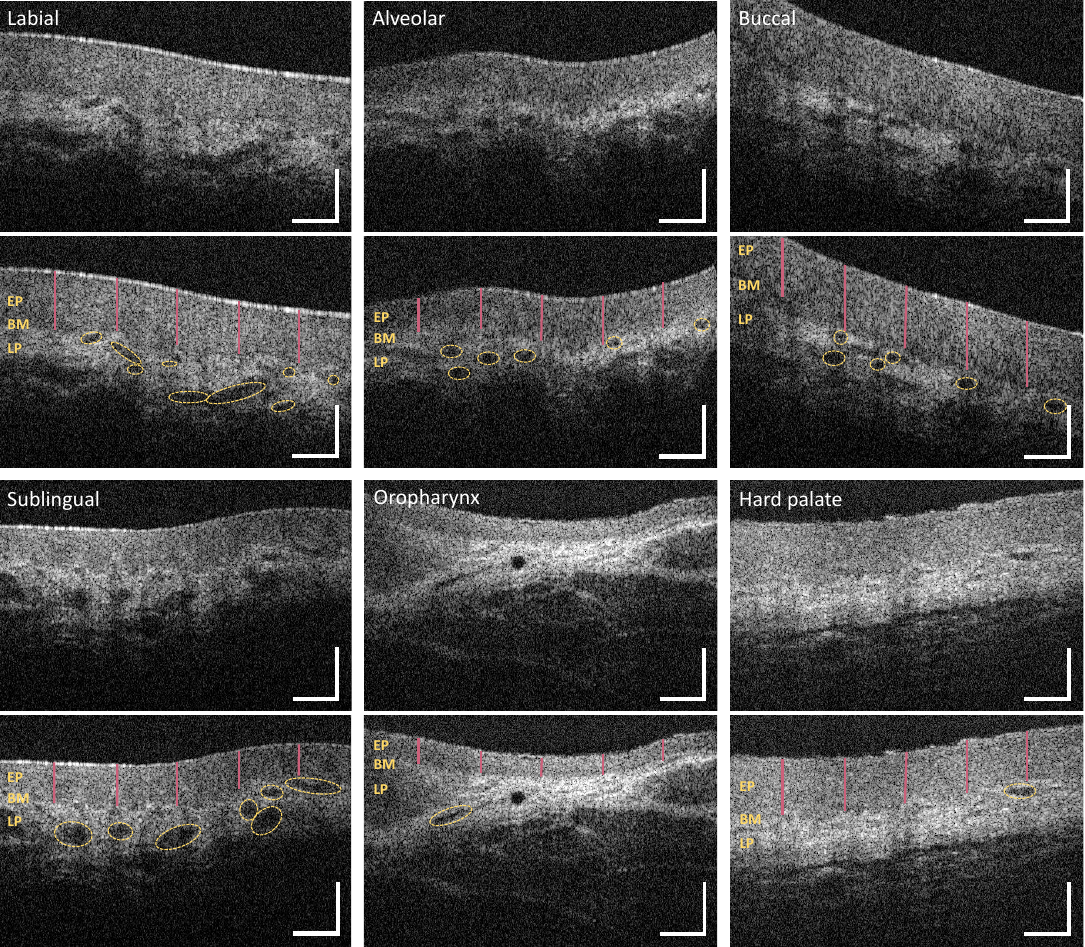
Figure A3. Representative OCT images of the human oral mucosa in vivo of the labial, alveolar, buccal and sublingual region as well as the oropharynx and the hard palate demonstrating the principle of the visual image analysis. EP:epithelium, BM:basement membrane, LP:lamina propria; Vertical lines: epithelial thickness measurement, Ellipsoidal shapes: marked regions of vascularization. Scalebars: 200 µ